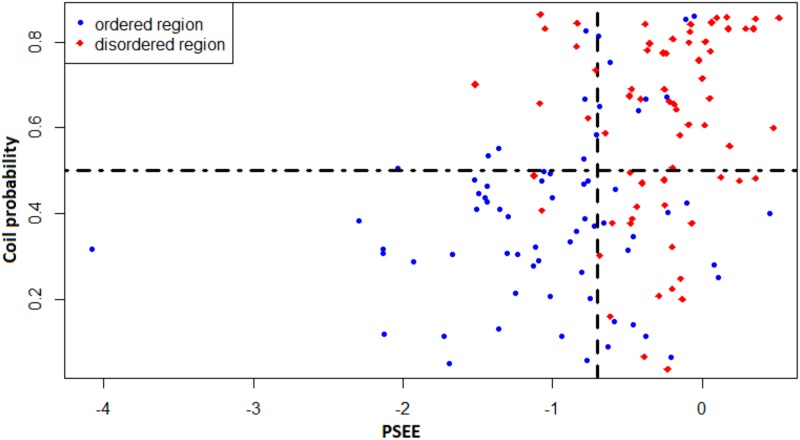
Correlation between PSEE and coil probability of ordered and disordered regions.PSEE and coil probability of ordered regions are marked by blue circles and those of disordered regions are marked by red diamonds. The vertical black dashed line separates the average PSEE of ordered and disordered region and the horizontal dash-dotted line separates the ordered and disordered regions with more and less 50% coil probability.